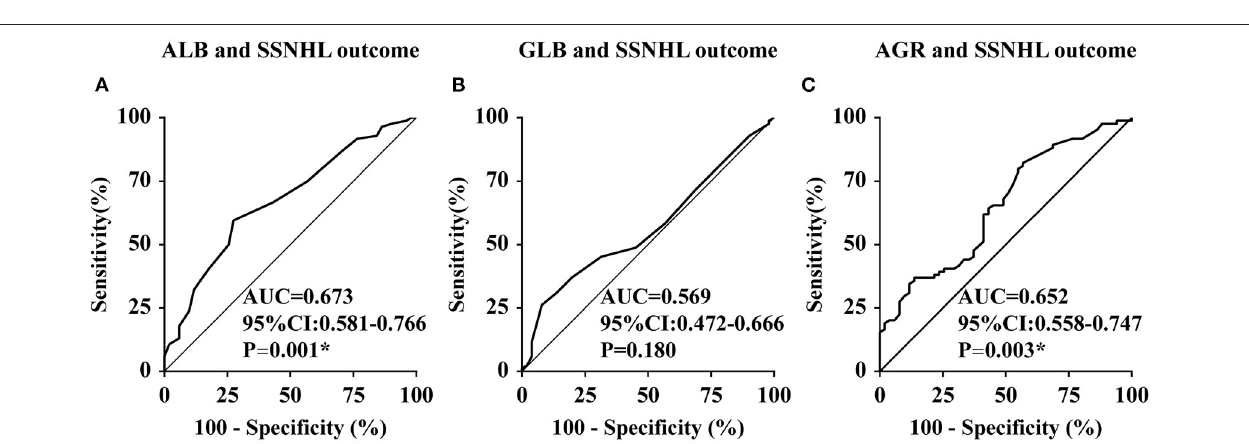
FIGURE 3 | Receiver operating characteristic curve analysis of ALB, GLB, and AGR levels for the prediction of the outcome of SSNHL. ALB, albumin; GLB, globulin; AGR, albumin-to-globulin ratio; CI, confidence interval; SSNHL, sudden sensorineural hearing loss; AUC, area under the curve; CI, confidence interval. *The correlation was significant at the 0.01 level ( p < 0.01). (A–C) represent the receiver operating characteristic curve analysis of ALB, GLB, and AGR levels for the prediction of the outcome of SSNHL,